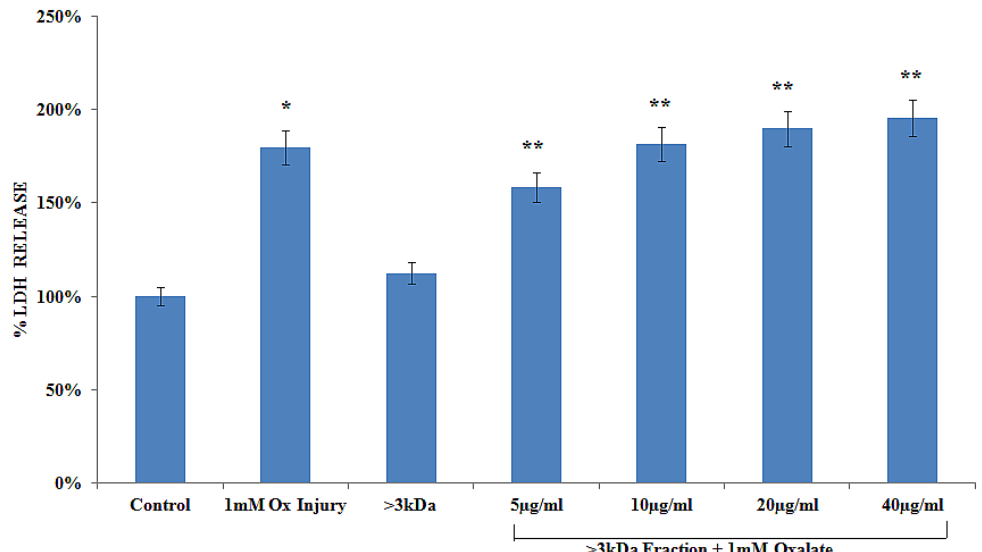
Figure 2 - Effect of >3kDa on the % LDH release. Data are mean ± SEM of three independent